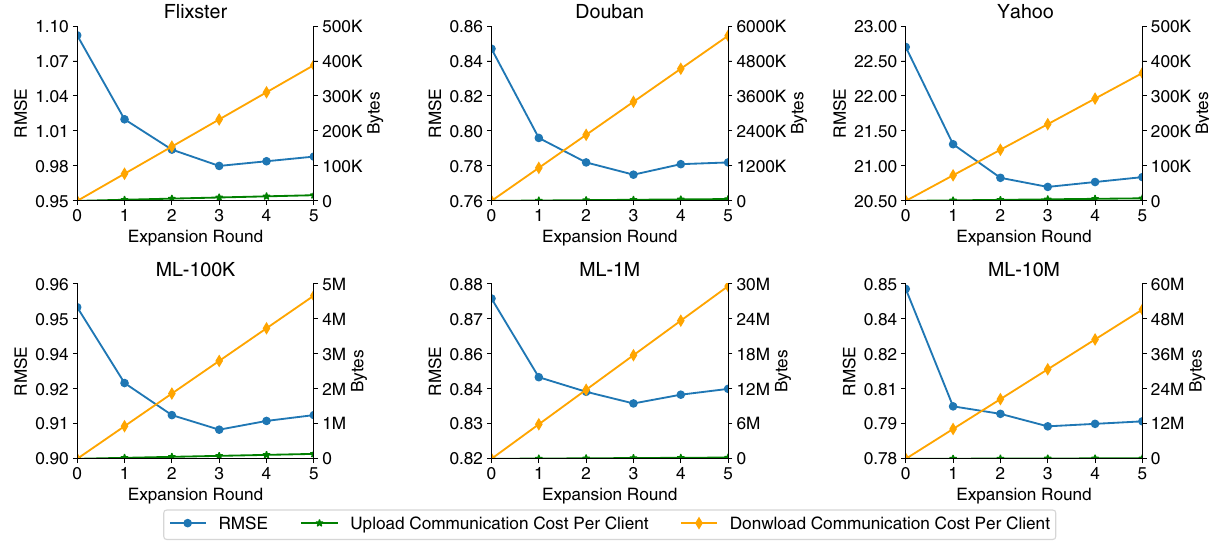
Fig. 6 The personalization RMSE and upload/download communication cost under different numbers of graph expansion rounds. The performance is optimal when there are three expansion rounds. The fi rst two rounds of expansion contribute most to the performance improvements, which indicate the graph information in the fi rst three orders is more important for personalization. The communication cost is proportional to the expansion rounds, and the download communication cost is much larger than